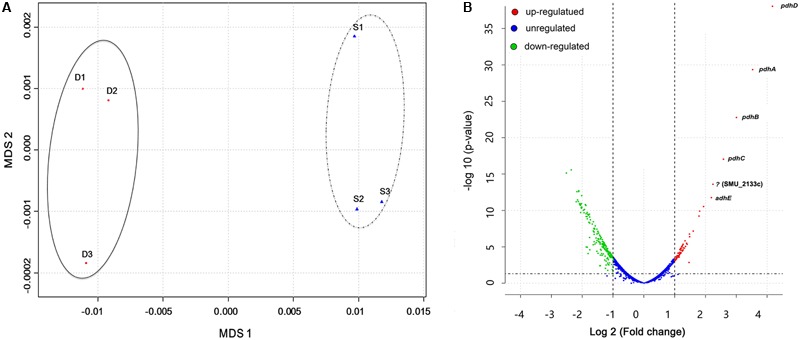
Overall transcriptomic changes of S. mutans within S. mutans–C. albicans dual biofilm. (A) Multi-Dimensional Scaling (MDS) plot based on Euclidean distances derived from a sample variance parameter, showing the level of correlation and reproducibility among samples. Red circles (D) show dual biofilm, whereas blue triangles (S) show single. Samples from single and dual biofilm group clustered together, respectively, indicating the different transcriptome pattern of S. mutans with and without C. albicans. (B) Plot showing fold change and levels of significance for differential expression for all genes.